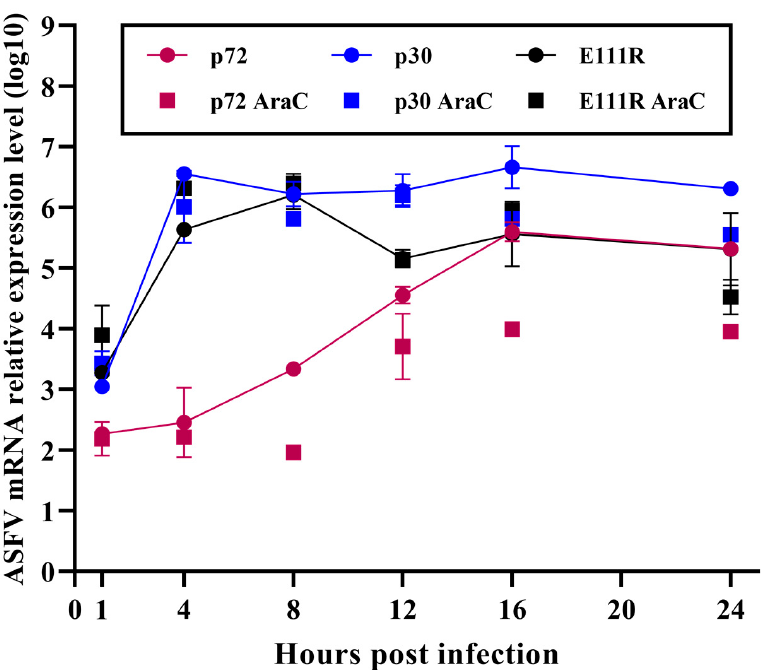
Figure 3. E111R gene transcript expression results. The graph shows the results of the expression of the E111R , CP204L , and B646L genes in the ASFV genome relative to the GAPDH gene. The RNA was collected from PAMs at 1, 4, 8, 12, 16, and 24 h after infection with ASFV (MOI = 3). Transcript levels of p30, p72, and E111R genes after ASFV SY18 (MOI = 3) infection of PAMs are indicated by a dash (circle marker), and data from the parallel treatment group treated with cytarabine (AraC, 100 µ g/mL) are shown as squares. The Y-axis uses the decimal (log10) logarithm to indicate the relative mRNA expression levels.